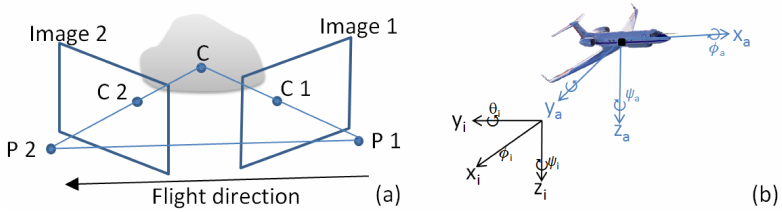
Figure 5. (a) Schematics of stereophotogrammetric observations of cloud point C from aircraft position P1 and P2 with projected image points C1 and C2. (b) Illustration of aircraft and camera coordinate